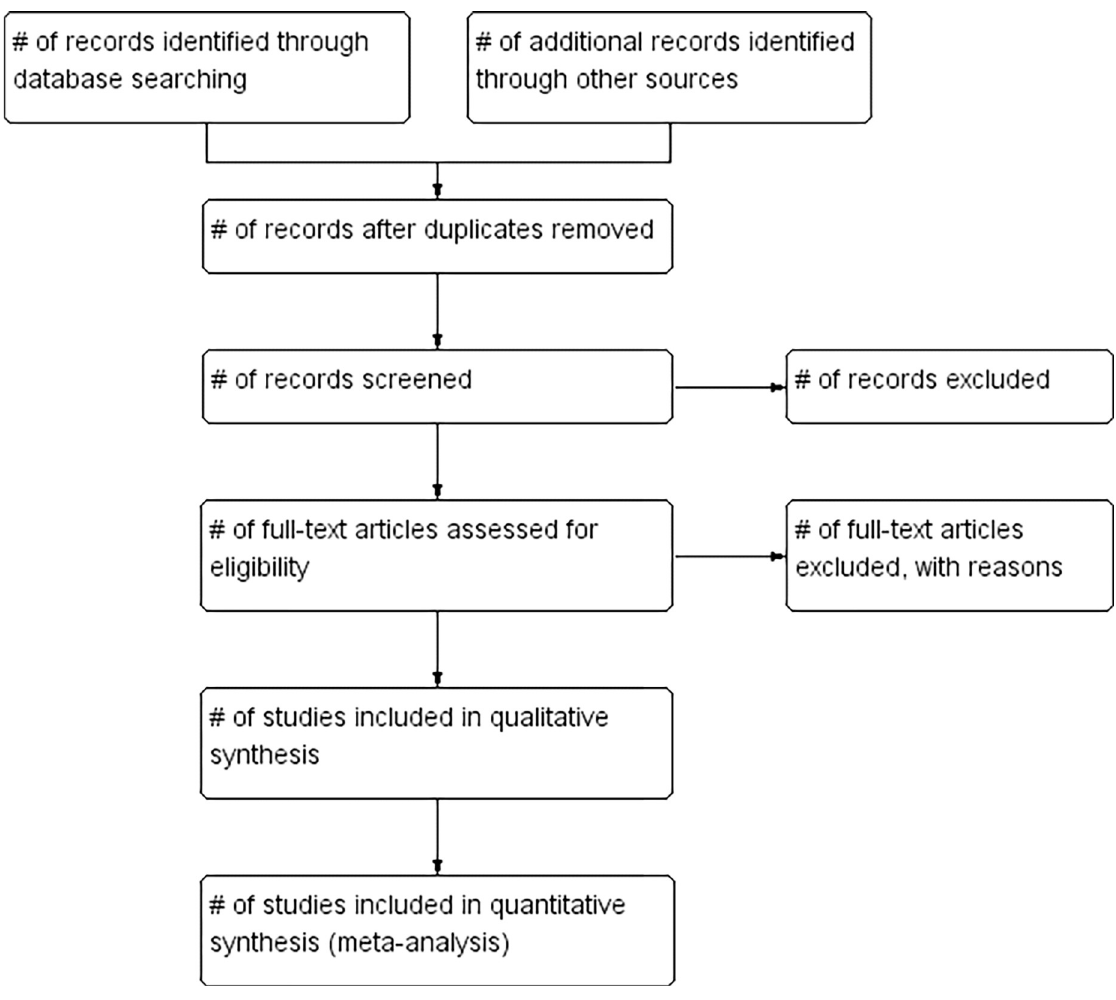
Fig 1. Flow chart of study